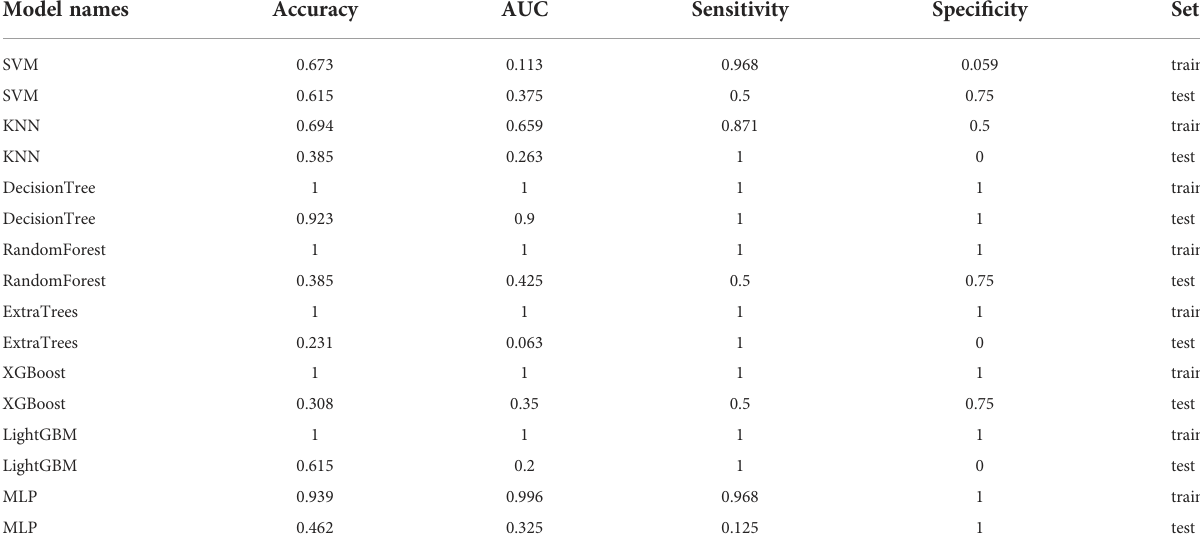
TABLE 12 Each evaluation index of the best performance of 100 random groupings in eight machine learning algorithms. Model